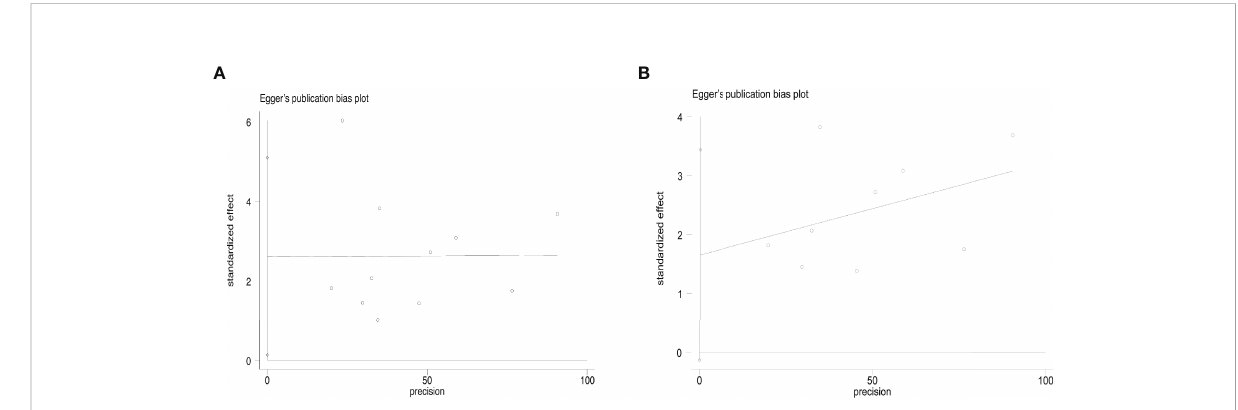
FIGURE 7 Egger ’ s funnel plot of the complication rate: (A) T1aN0M0 and T1bN0M0 studies, (B) MWA and RFA studies.